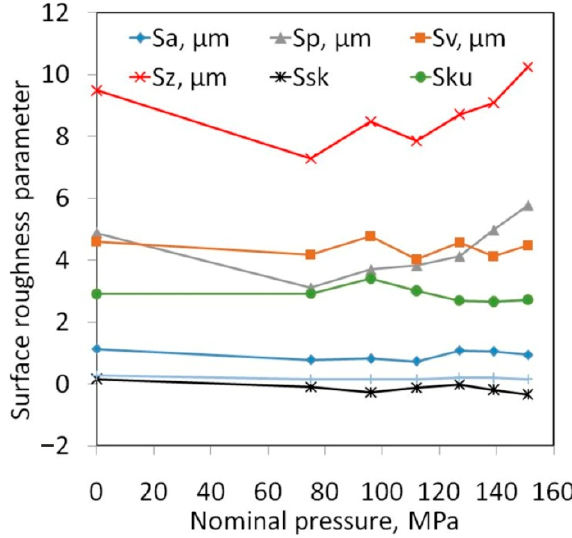
Figure 7. Influence of nominal roller pressure on the value of the Sa, Sp, Sv, Sz, Ssk and Sku parameters.